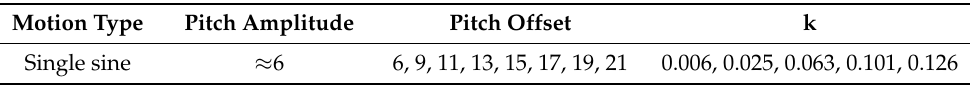
Table 2. Summary of the monosine experiments performed at different parameters.